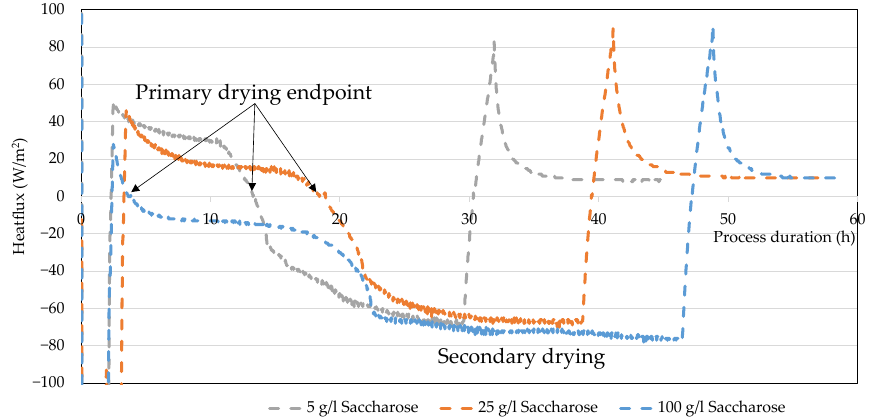
Figure 18. Heat flux data over primary and secondary drying of saccharose solutions with different concentrations.